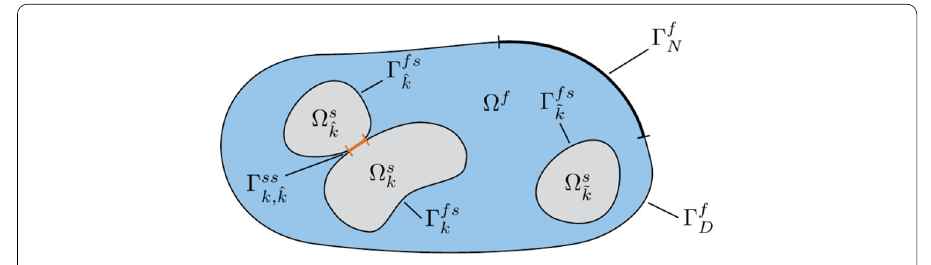
Fig. 1 Domain (cid:2) consisting of several disjunct domains, the fluid domain (cid:2) f and the solid sub-domains (cid:2) s k representing rigid bodies k , with fluid–solid interface (cid:3) fs k and solid-solid interface (cid:3) ss between the rigid bodies k and ˆ